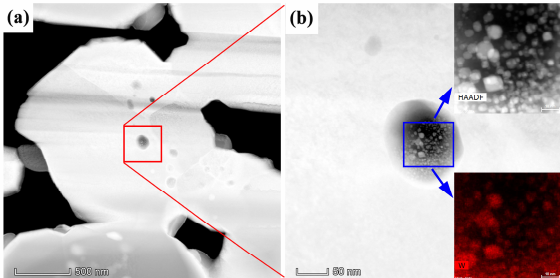
Figure 7. High spatial resolution characterization of a Sc-containing particle located in the interior region of a W grain. ( a ) Low-magnification HAADF image showing the near-surface region of the cathode; ( b ) zoomed HAADF micrograph corresponding to the red box in ( a ). Inset in ( b ) are a HAADF image and W elemental distribution map, revealing nanoscale W particles within the 100 nm Sc-containing